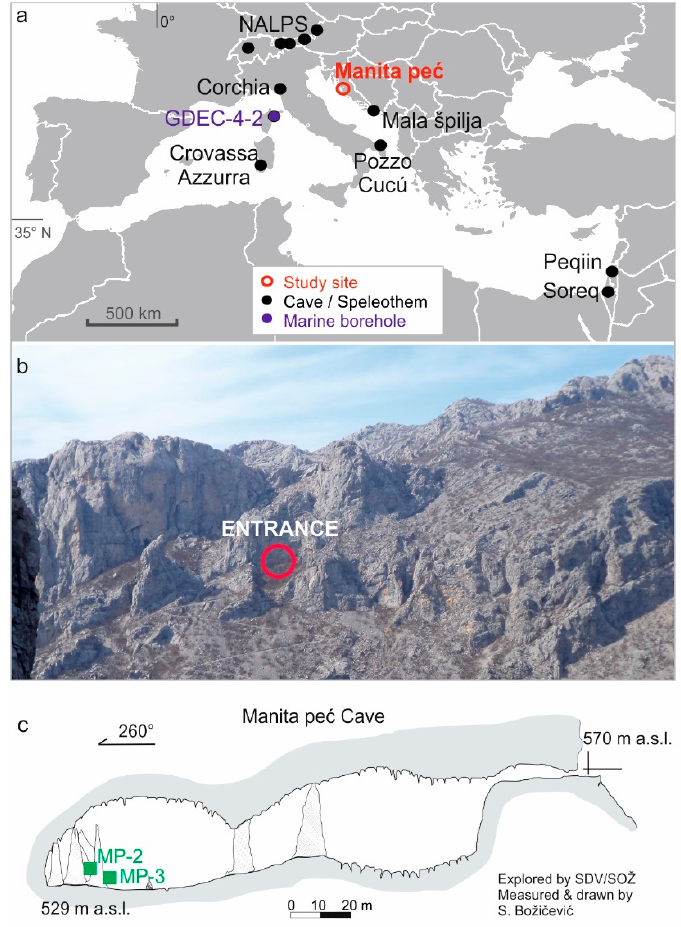
Figure 1. ( a ) Location of Manita pe´c Cave and other palaeoclimate archives used for comparison: North Alps (NALPS) caves [4,36], Mala špilja Cave [27], Corchia Cave [15], Crovassa Azzurra Cave [24], Pozzo Cucú Cave [25], Soreq and Peqiin caves [33] and marine borehole GDEC-4-2 [59]. The position of NGRIP ice core, which is not shown here, is 75°5 ′ N, 42°19 ′ W [2]. ( b ) Cave entrance on the steep and bare side of the Paklenica canyon, Velebit Mountain. ( c ) Cave survey with marked speleothems positions (green squares and IDs).